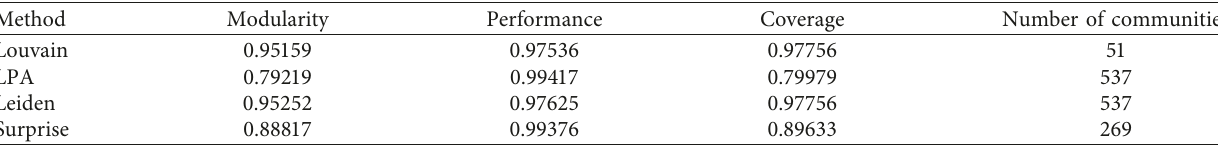
Table 18: For replying interaction networks from March 11 until May 26 in 2021, useful metrics for evaluation of the community detection algorithms, and number of communities identified in each.